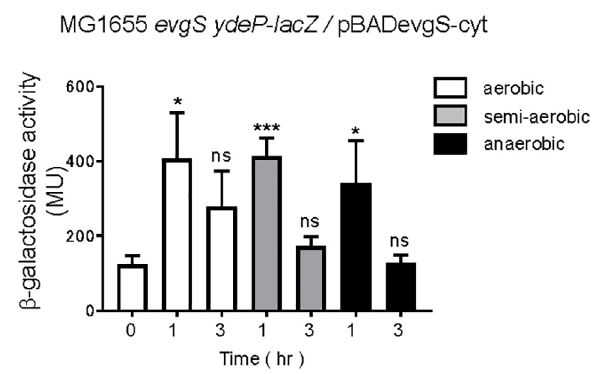
FIGURE 7 | Aeration is not necessary for EvgS/EvgA activation in strains expressing the cytoplasmic region of EvgS (EvgS-Cyt). Activity of the ydeP-lacZ reporter in different culturing conditions (upper panel). Cells were grown in EvgS-activation medium with 0.02% arabinose under aerobic (white bars), semi-aerobic (gray bars), or anaerobic condition (black bars) at 37 ◦ C. Optical density at 600 nm of the cell cultures subjected to reporter assays is shown in Supplementary Figure 11 . Data represent the average of three biologically independent replicates. Error bars indicate the standard deviation, and statistical analyses of each redox condition group were performed as described in Figure 1 . ns, not significant; *0.01 ≤ p < 0.05; *** p <